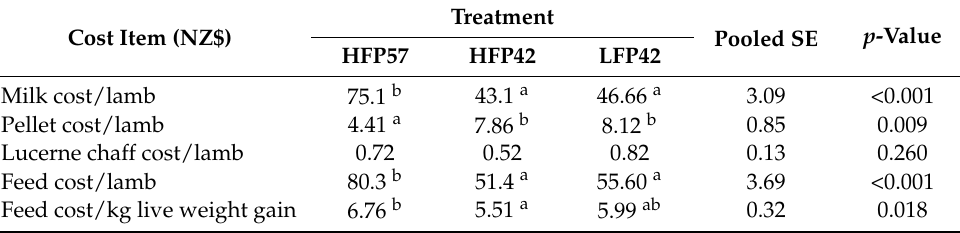
Table 9. Feed cost analysis of lambs reared artificially using three different rearing regimens: HFP57, commercial milk replacer, high fibre concentrate pellets and milk feeding to 57 days of age; HFP42, commercial milk replacer, high fibre concentrate pellets and early weaning at 42 days of age; LFP42, high protein milk replacer from 2–16 days of age followed by commercial milk replacer, low fibre concentrate pellets and early weaning at 42 days of age. Cost Item